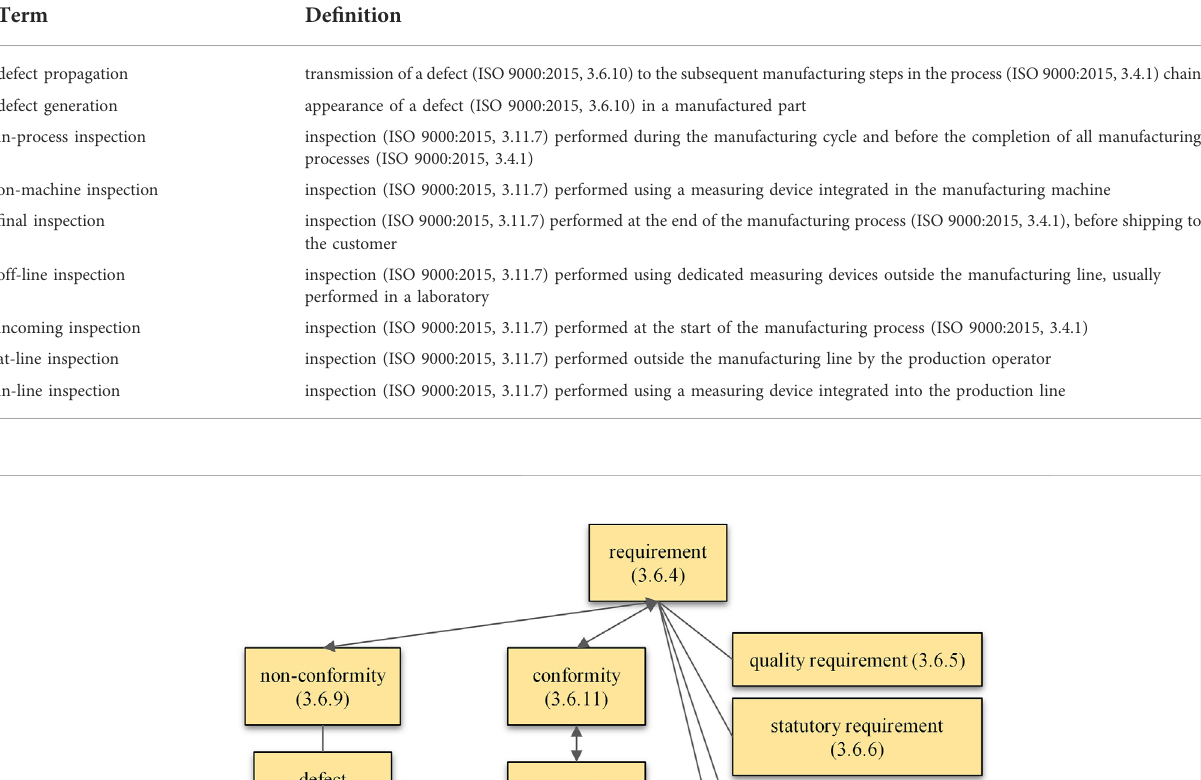
TABLE 1 Examples of proposed de fi nitions during the